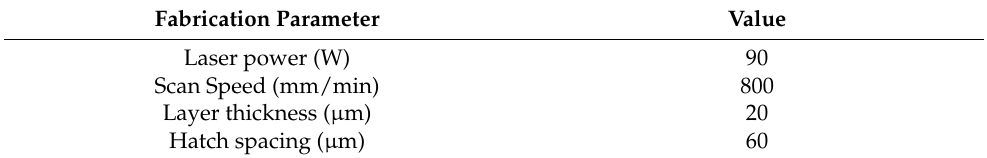
Table 1. Selective Laser Melting processing parameters for Mysint 100 machine utilized in the study.